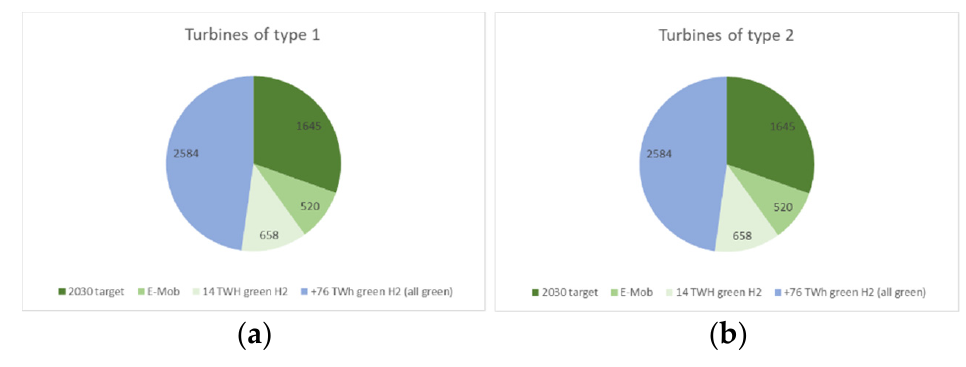
Figure 3. Turbine demand for both types.